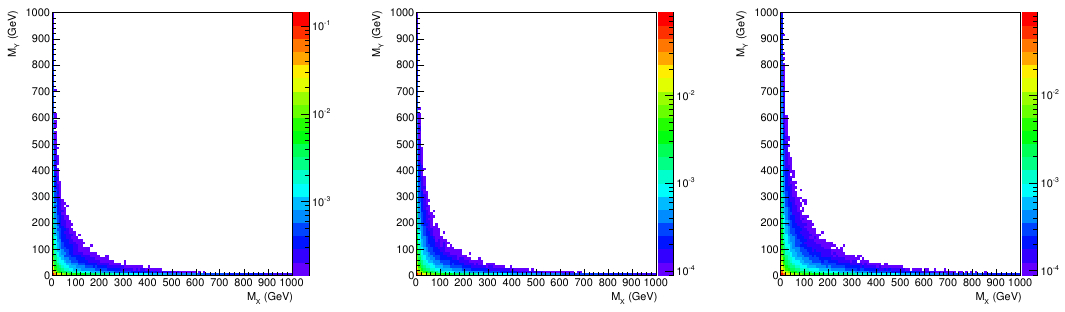
Figure 14 . Correlations in masses of the remnant systems for the double inelastic contribution for three di(cid:11)erent F 2 structure functions: LUX-like, ALLM97, SU for